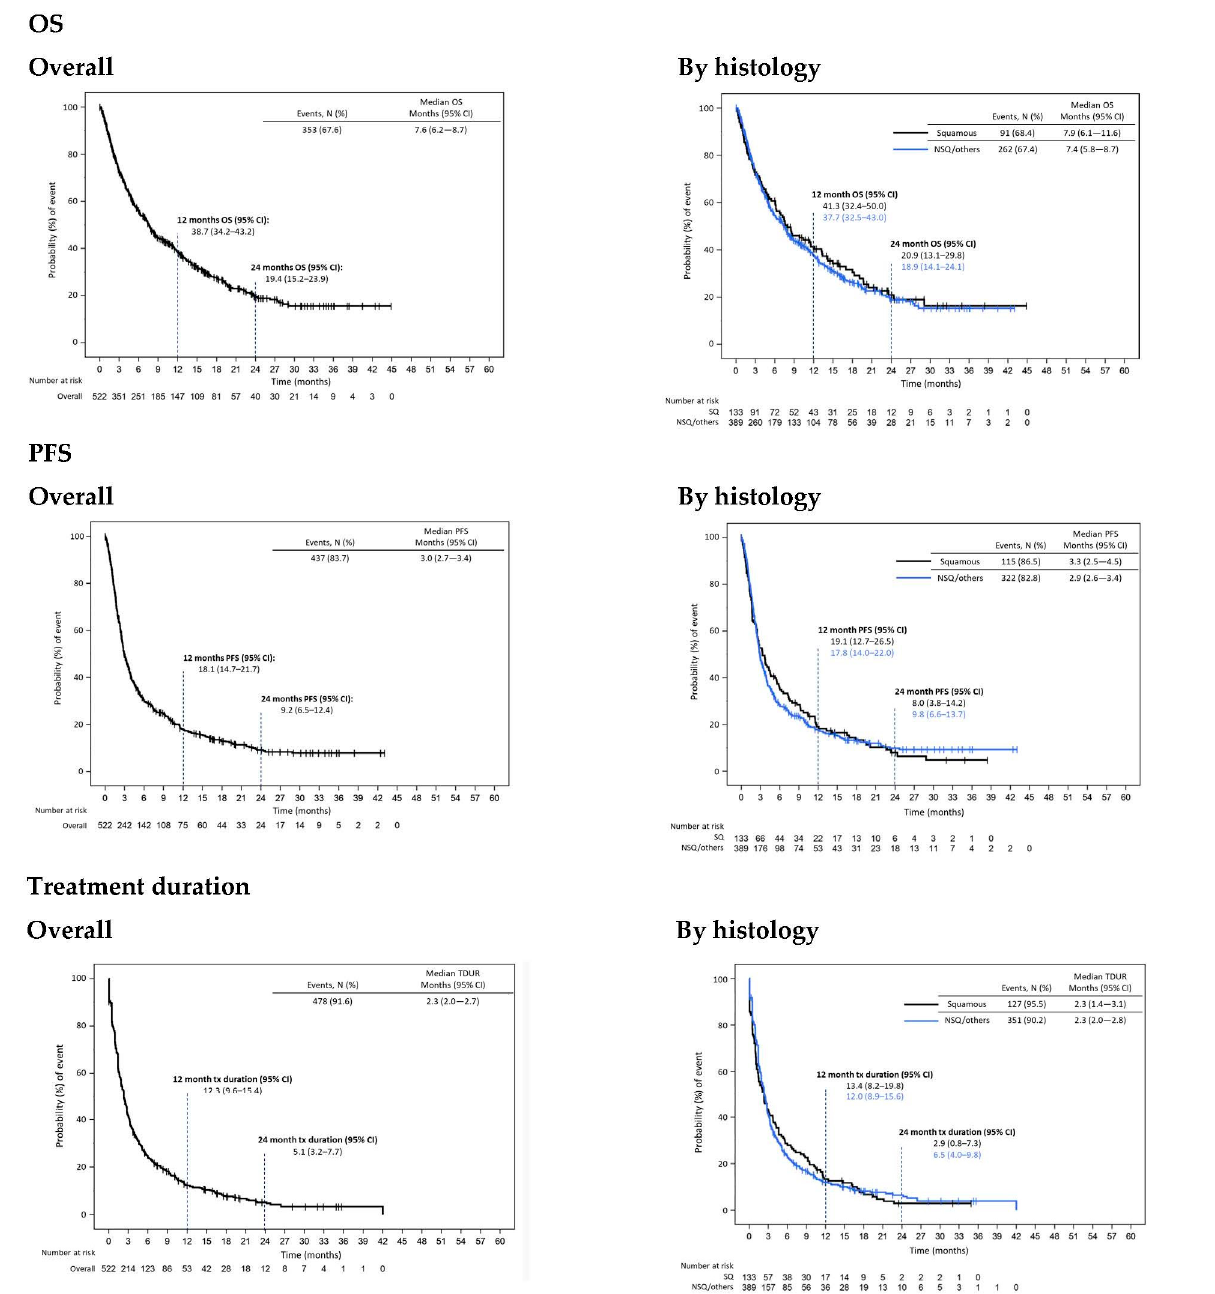
Figure 2. OS, PFS and treatment duration by histology in patients treated with nivolumab in CRISP (index date = nivolumab start date).